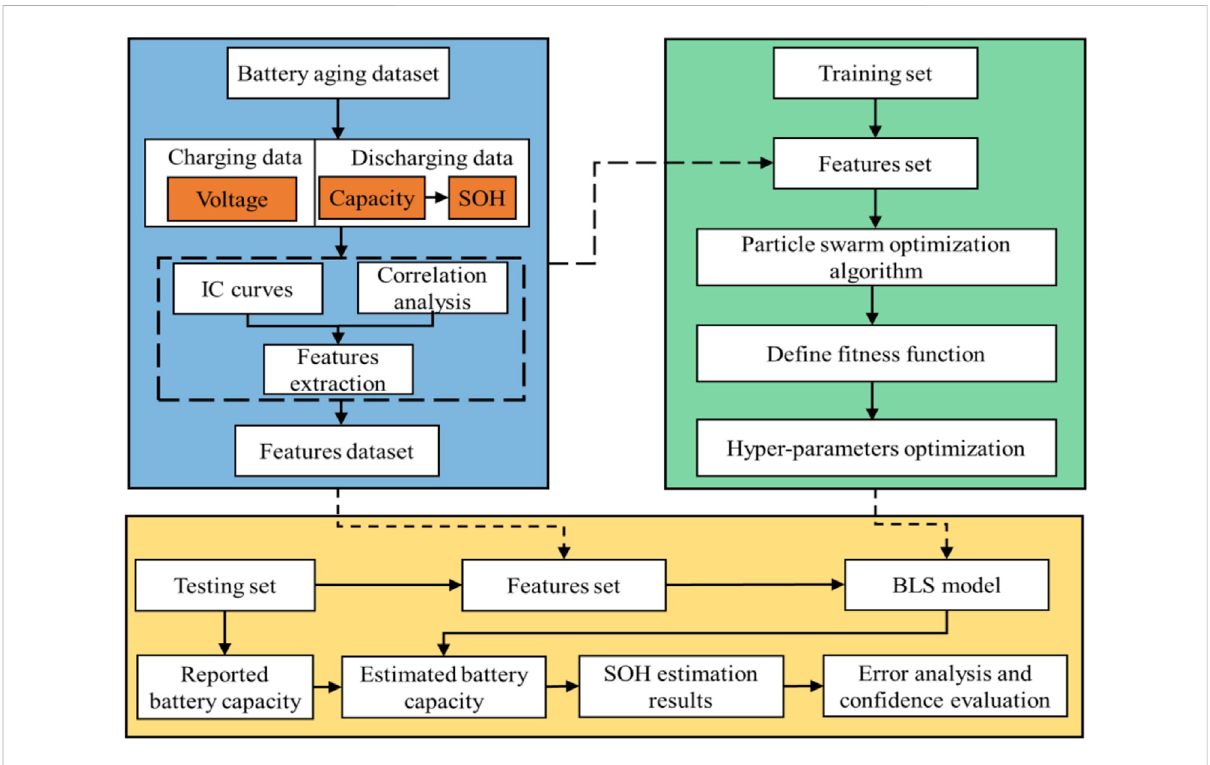
FIGURE 6 The framework of the proposed SOH estimation method based on the PSO-BLS